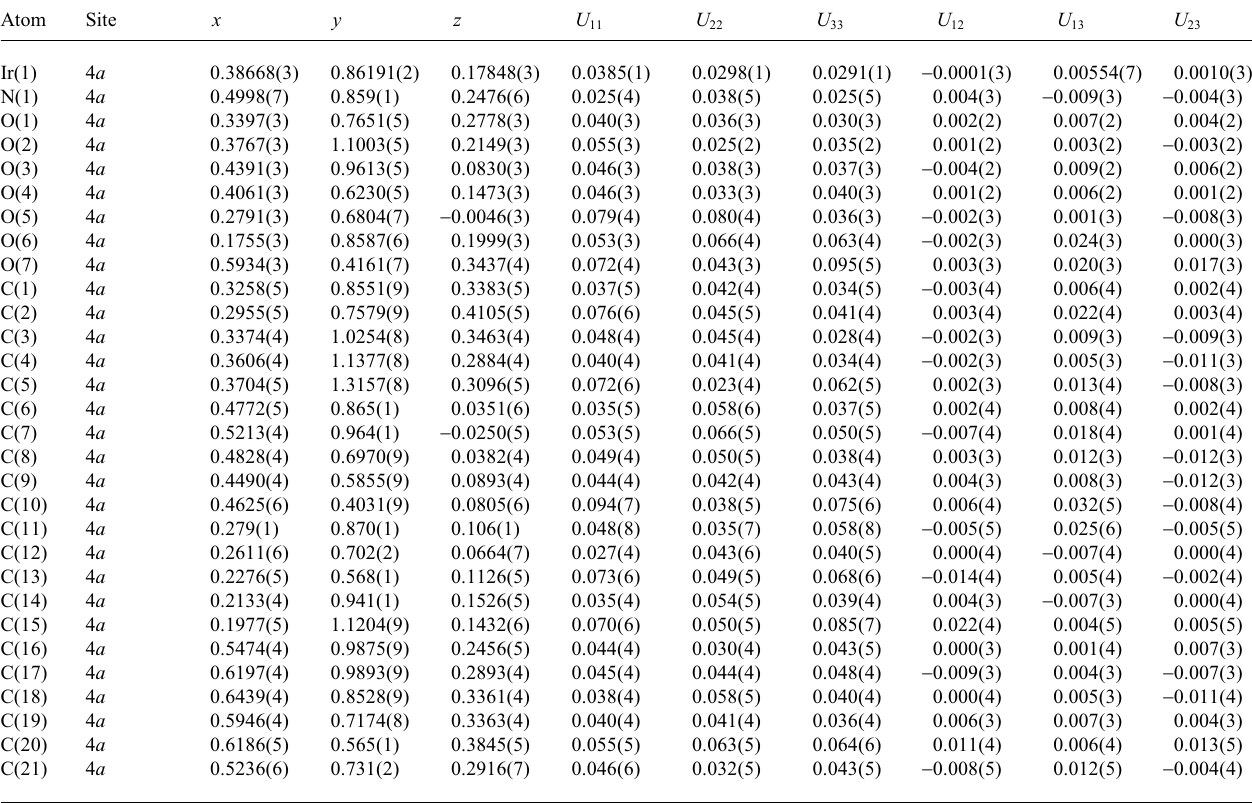
Table 3. Atomic coordinates and displacement parameters (in Å 2 ).